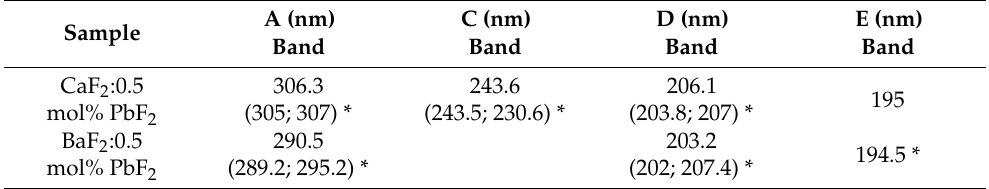
Table 3. Maxima of the optical absorption bands of CaF 2 :0.5 mol% PbF 2 and BaF 2 :0.5 mol% PbF 2 crystals as a result of the absorption spectra and by Gaussian multi-peak fitting *.